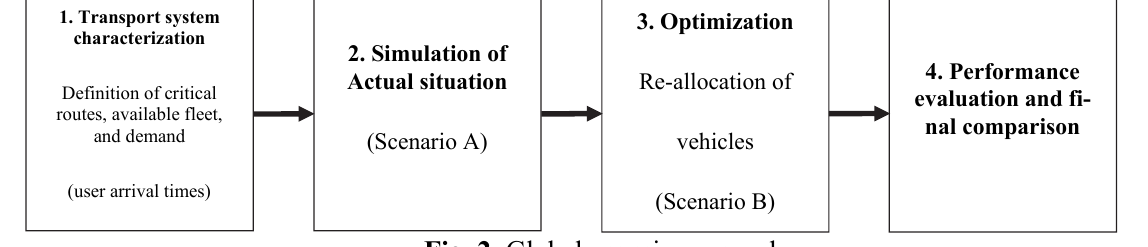
Fig. 2 . Global generic